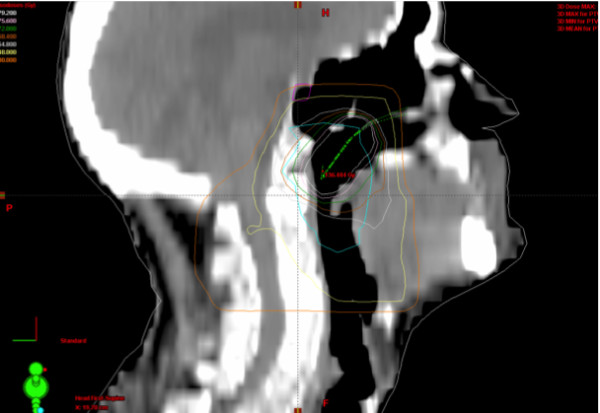
The sagittal view of the dose distribution of the sum of external beam radiotherapy and the brachytherapy in patients with cancer of the epipharynx. Volumes of interest and isodose lines are presented. Abbreviations: PTV-T= Planning target volume for the external beam.